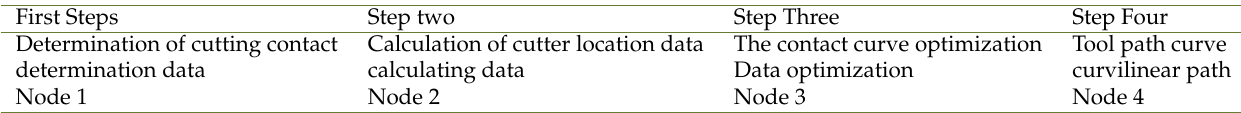
Table 1. The algorithm involves points